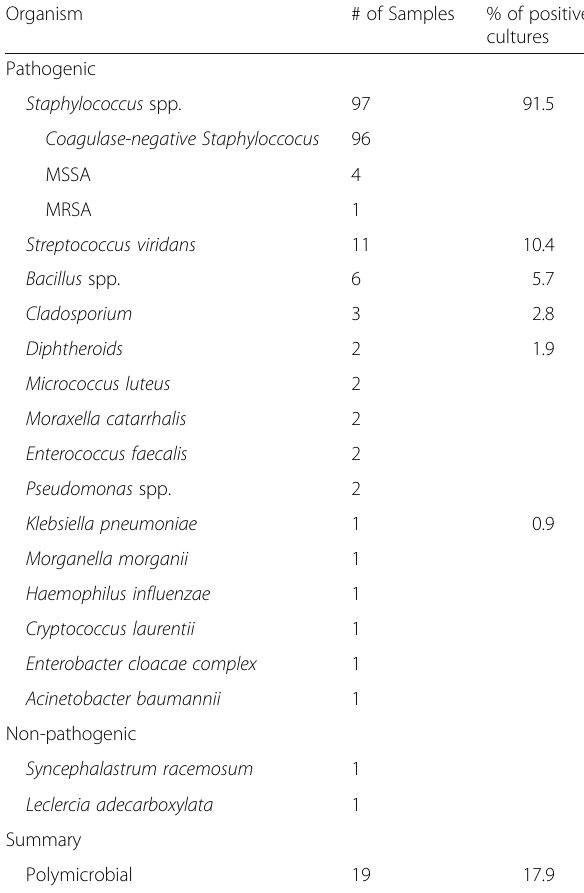
Table 4 Infectious agents in open globe